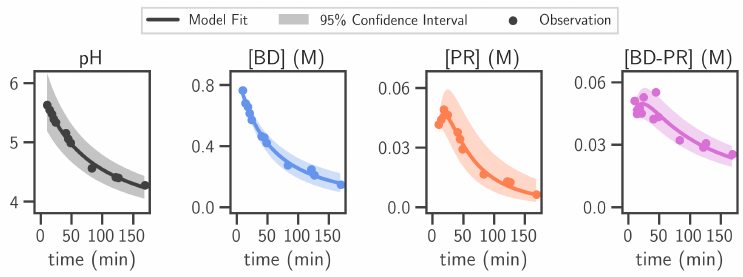
Figure 3. Comparison of measurement and model fit of 0.9M BD/0.9M NH x solution. The butenedial/NH x model kinetic mechanism was fit to measurements of this solution. The output (best model fit and 95% confidence interval) and observations are shown for all modeled species. NH x was not measured explicitly but was assumed to be consumed at a 1:1 ratio with butenedial. pH was estimated empirically outside of the model fit. Only the best model fit of pH was taken as input into the model kinetic mechanism, although the 95% confidence interval is reported for the empirical fitting of